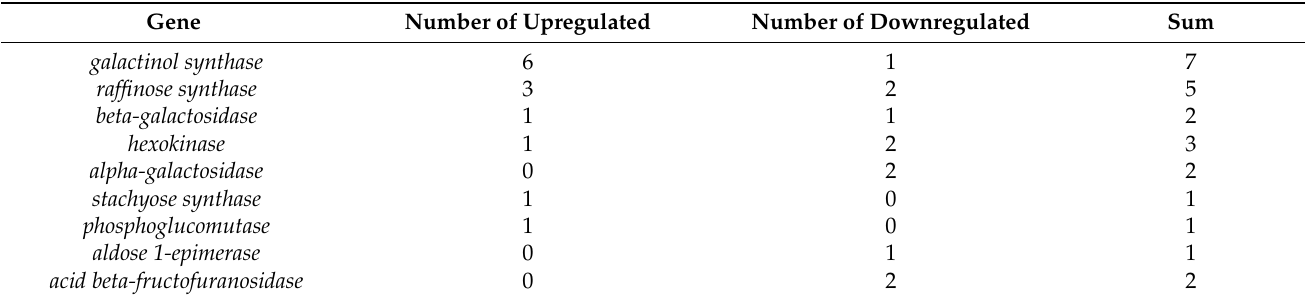
Table 3. DEGs related to galactose metabolism in the GL